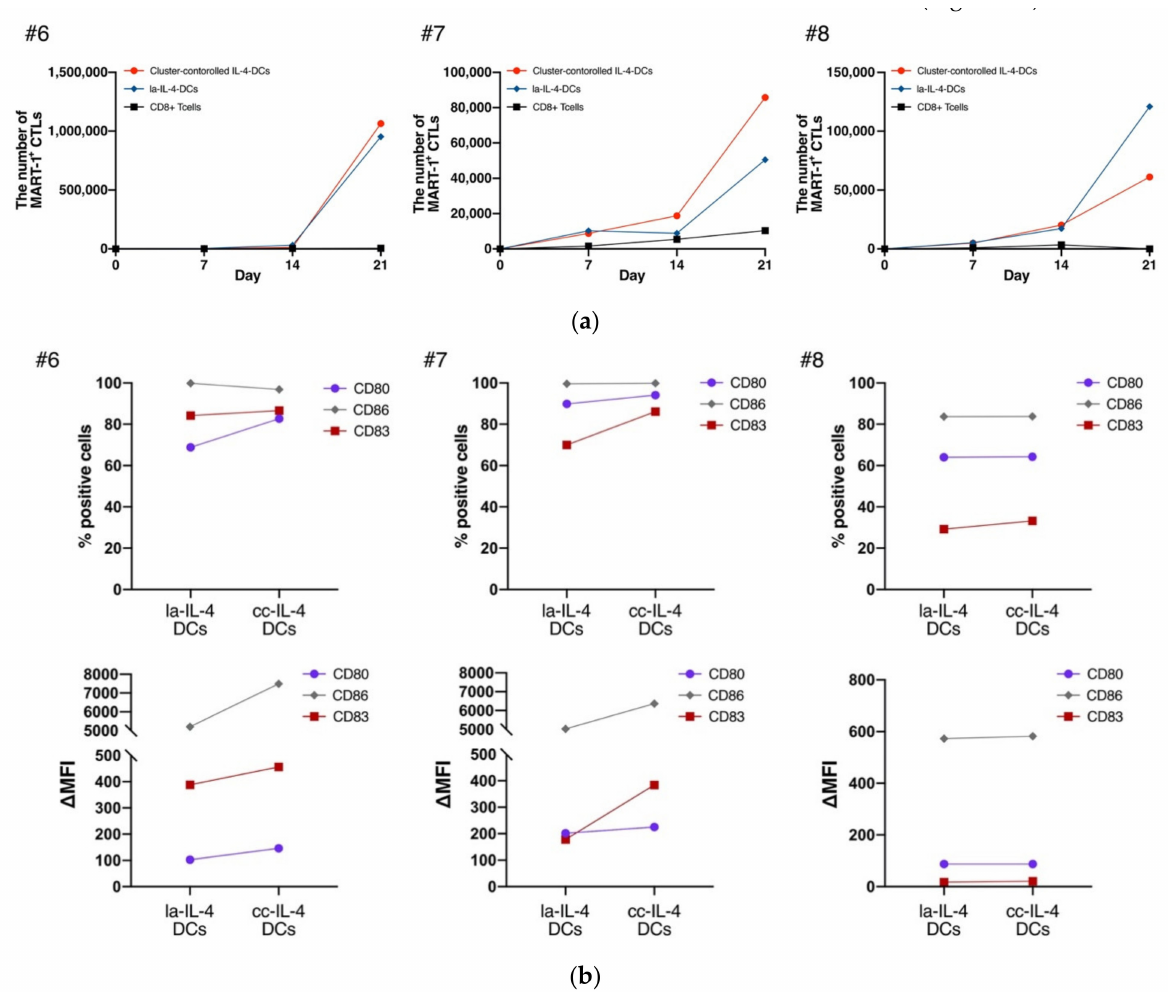
Figure 4. Comparison of MART − 1 specific CTL induction in low − adherent IL-4 − DCs (la − IL-4 − DCs) and cluster − controlled IL-4 − DCs (cc − IL-4 − DCs). la − IL-4 − DCs or cc − IL-4 − DCs were cocultured with autologous T cells at a ratio of 1:10 DCs:T cells ( a ) Seven to 21 days after the start of the co − culture, MART − 1 specific CTLs were detected by CD3, CD8, and MART − 1 + tetramer via flow cytometry. The number of MART − 1 tetramer + CTLs in the culture period is presented in line graphs ( n = 3). ( b ) Comparison of DC maturation markers in the groups with MART − 1 specific CTL induction detected by flow